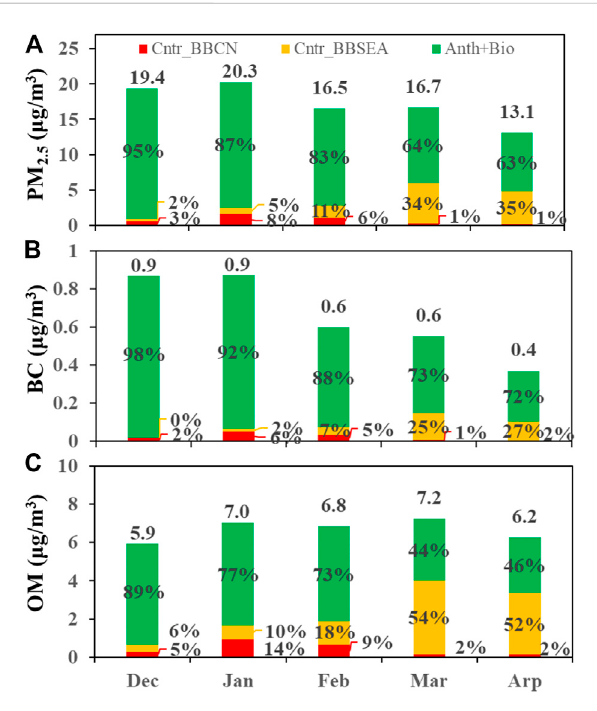
FIGURE 4 Modeled monthlyand NSCS regional meanconcentrationsof (A) PM 2.5 , (B) BC, and (C) OM. Numbers on top of each bar are the mean concentrations. Contributions from anthropogenic and biogenic sources (NOBB, green), biomass burning emissions from mainland Southeast Asia (Cntr_BB SEA , red), and biomass burning emissions from China (Cntr_BB CN , orange) are shown in percentages. The NSCS region is indicated in Figure